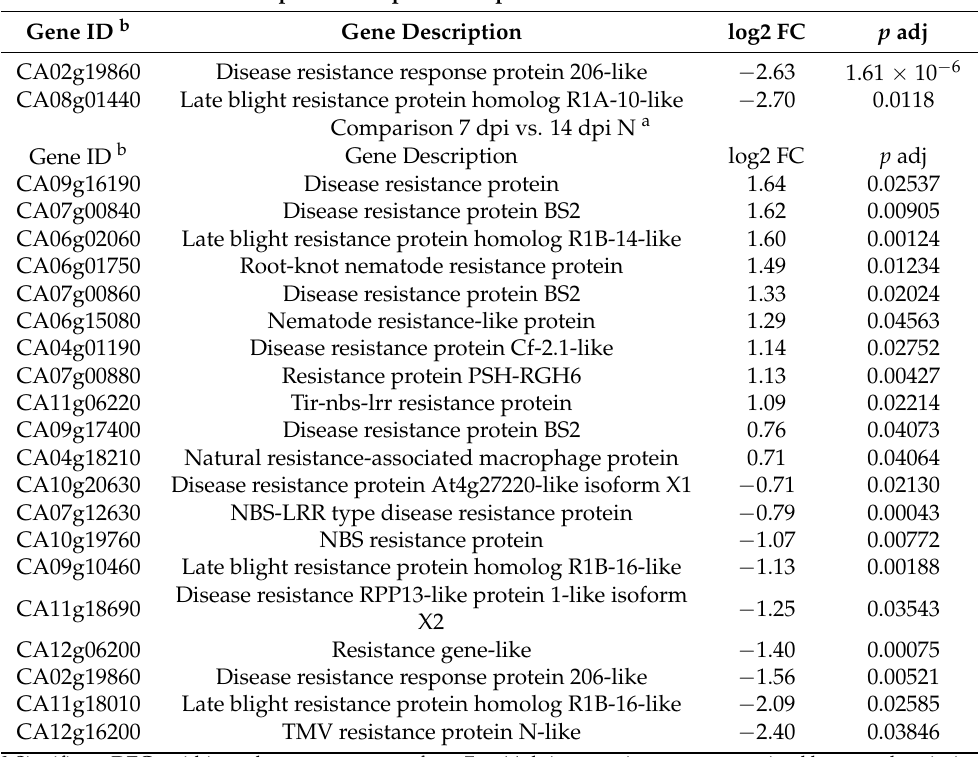
Table 3. Cont. Comparison 7 dpi vs. 14 dpi Buffer-Mock Control a